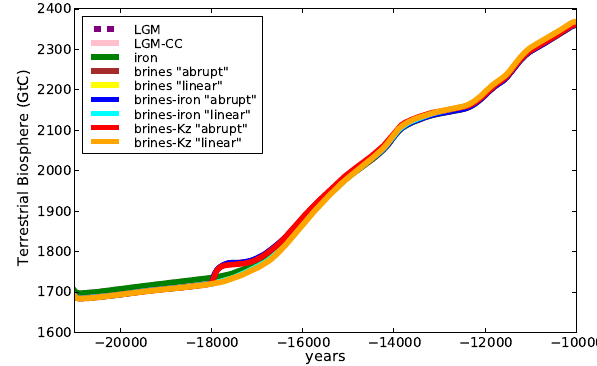
Fig. 9. Evolution of the carbon stock from the terrestrial bio- sphere (GtC) during the deglaciation for the simulations as defined in Fig. 6, when the terrestrial biosphere is